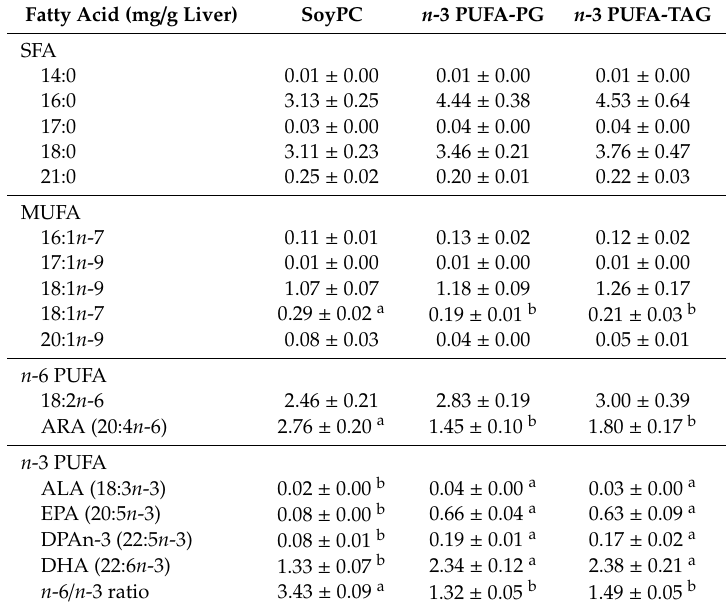
Fatty Acid (mg / g Liver) SoyPC n -3